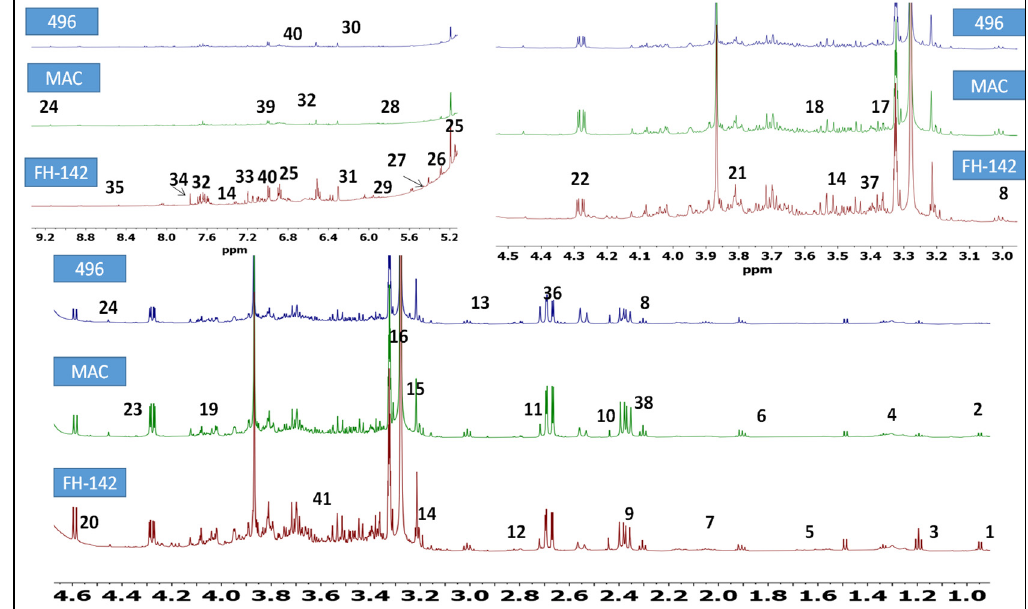
Figure 1. Annotated bioactive constituents in G. hirsutum cultivars (NB-01, non-pest-resistant variety); PR-01 (pest-resistant American variety); PR-02 (transgenic pest-resistant variety having Cry proteins, Bt cotton). (1) nonanoic acid, (2) valine, (3) alanine, (4) citrulline, (5) arginine, (6) limonene, (7) linoleic acid, (8) γ -aminobutyric acid; (9) malic acid, (10) succinic acid, (11) terpinolene, (12) di-allylic methy-